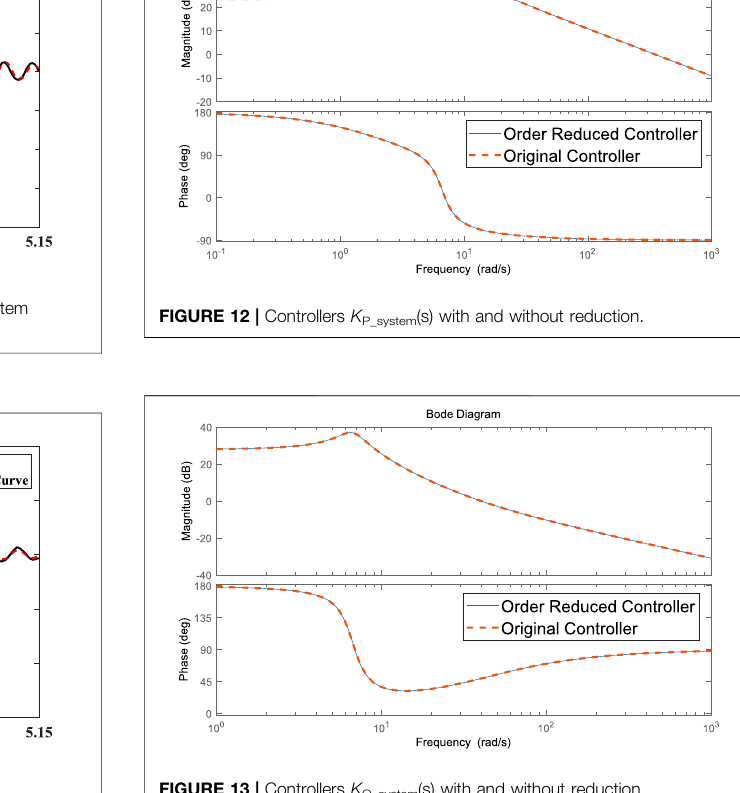
FIGURE 11 | Identi fi ed results for the active power-controlled system G Q_system